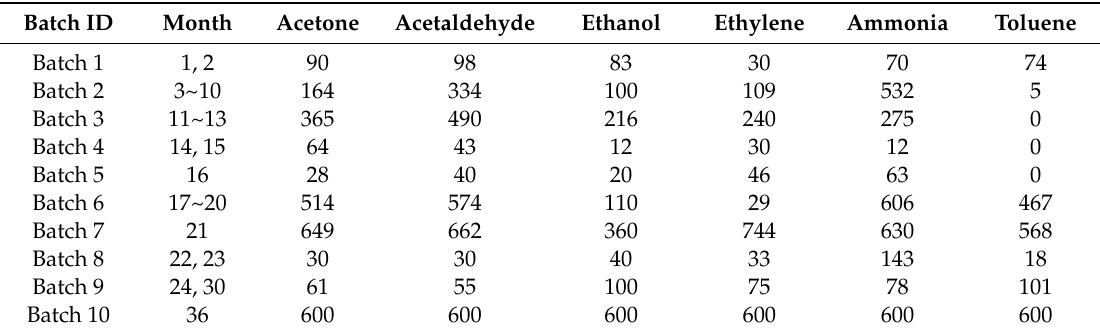
Table 1. Sensor drift benchmark